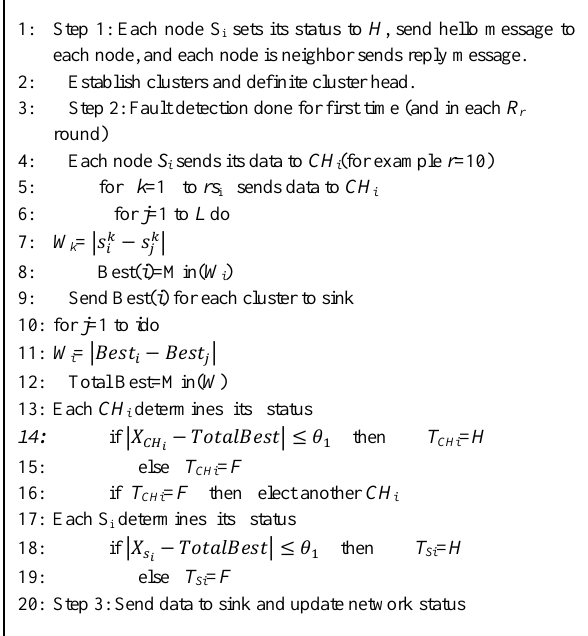
Figure 6. Pseudo code of the first to third